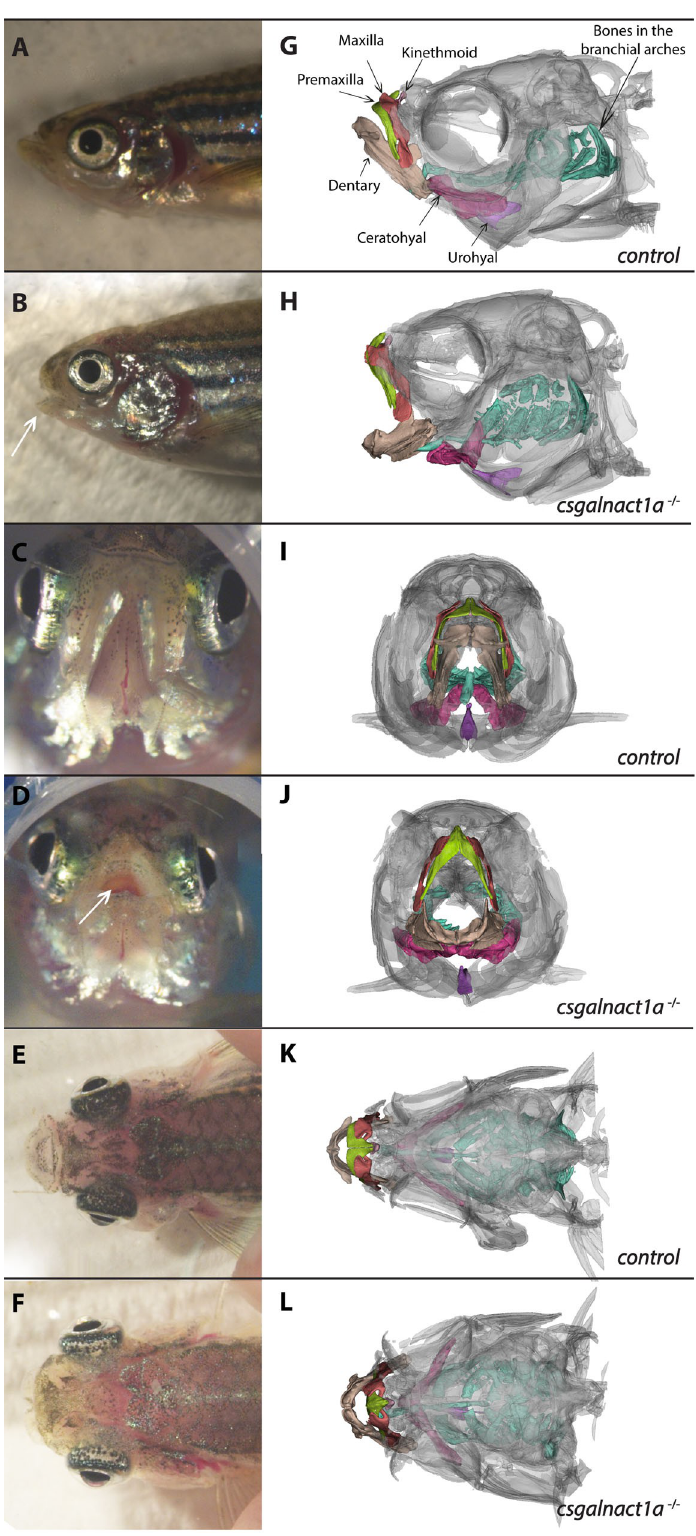
Fig 2. Csgalnact1a -/- adults display obvious craniofacial malformations. Bright field images of zebrafish heads (A-F) and corresponding 3D reconstructions of microCT scans (G-H). Different skeletal elements are highlighted